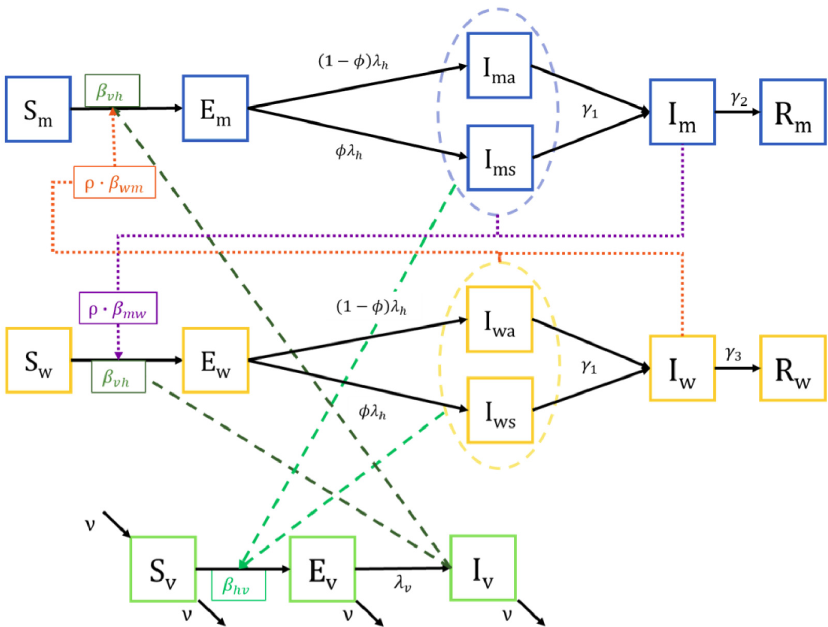
Fig 1. Mosquito and sexual transmission model for the Zika Virus. Susceptible men ( S (